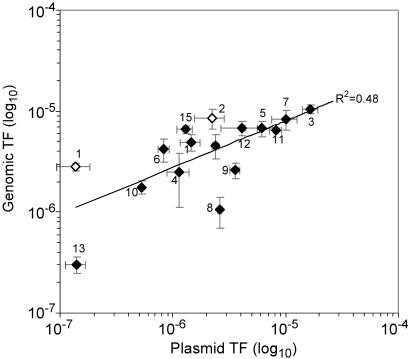
Correlation between recombination frequencies obtained with plasmid DNA and genomic DNA after natural transformation of R. solanacearum GMI1000 as recipient.Donor DNA belongs to the same strain and was either plasmid DNA containing 2 kb long R. solanacearum DNA or genomic DNA from recombinant strains (see the text). The numbers along the curves refer to the DNA position acronym with white and black symbols for chromosome and megaplasmid positions, respectively (TCP2<detection limit, TMP3, not determined). TF, transformation frequency.